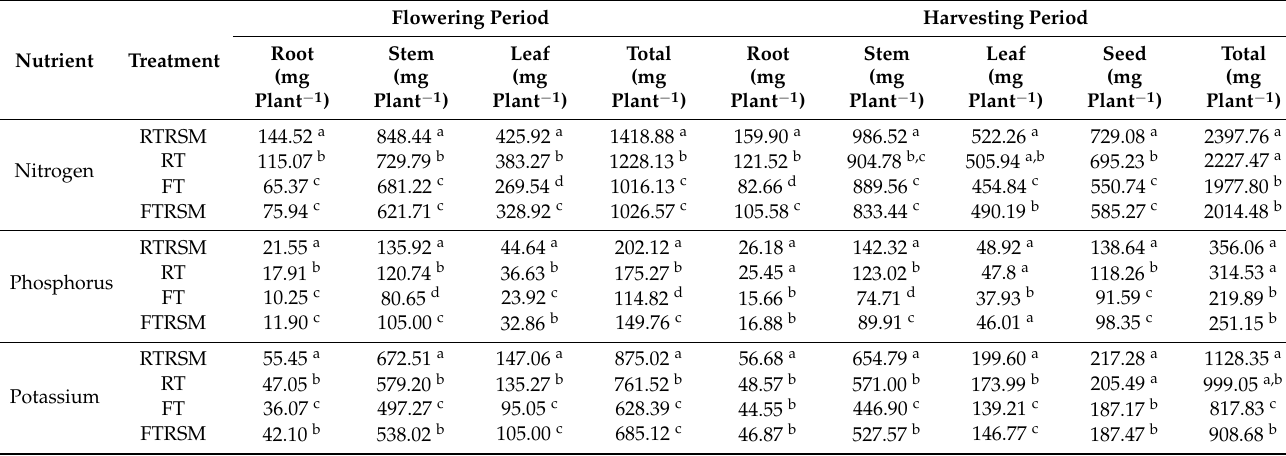
Table 5. Nitrogen, phosphorus and potassium accumulation of faba bean in different organs under different treatments at different